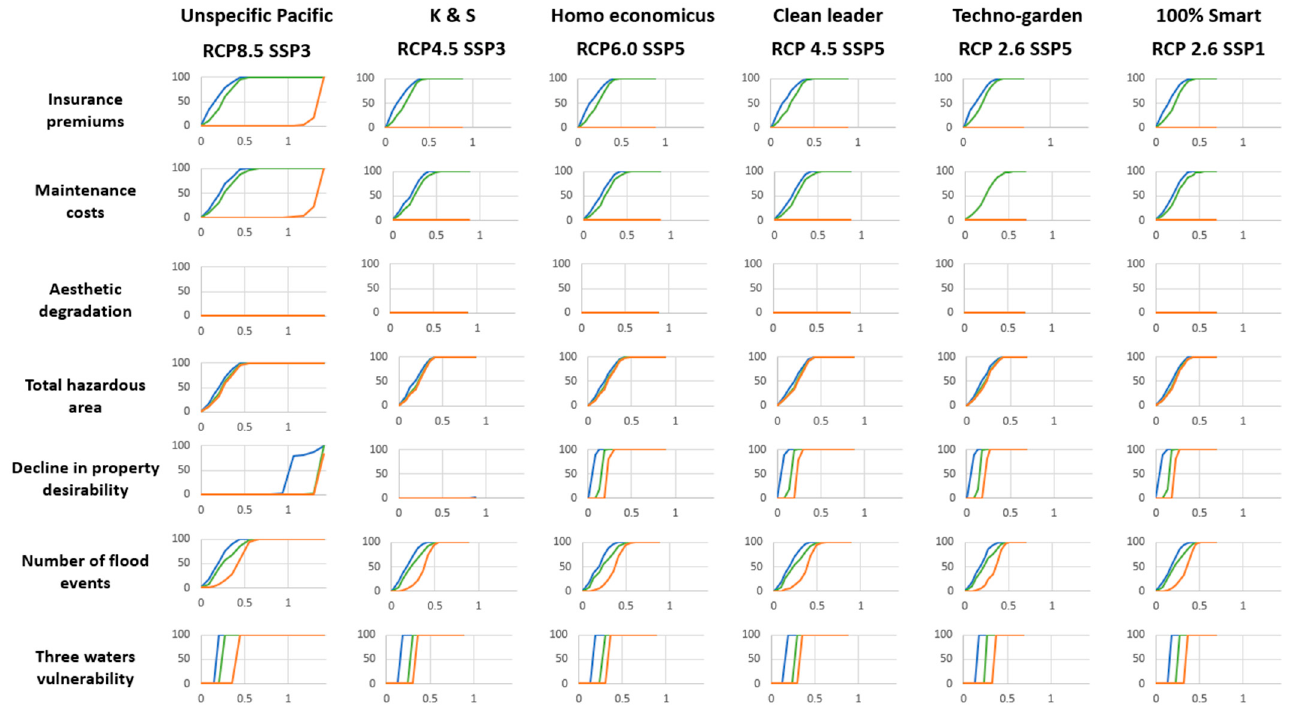
Figure 7. Activation time of signals, triggers and adaptation thresholds for the seven indicator variables without implementation of DAPP.